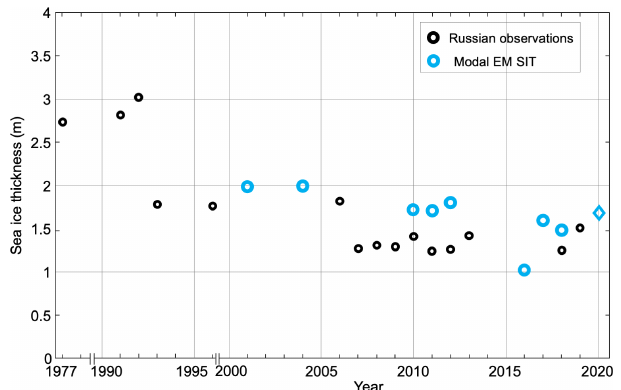
Figure 5. Sea ice thickness observations conducted on regular tourist cruises from Franz Josef Land to the North Pole in July– August. SIT was determined using visual observations from AARI ice specialists or TV-complex calculations and averaged over a tran- sect from 86 to 90 ◦ N, along the 50 ◦ E meridian (see black line Fig. 1a). Light blue markers indicate the time series of modal AOI EM SIT (Fig.